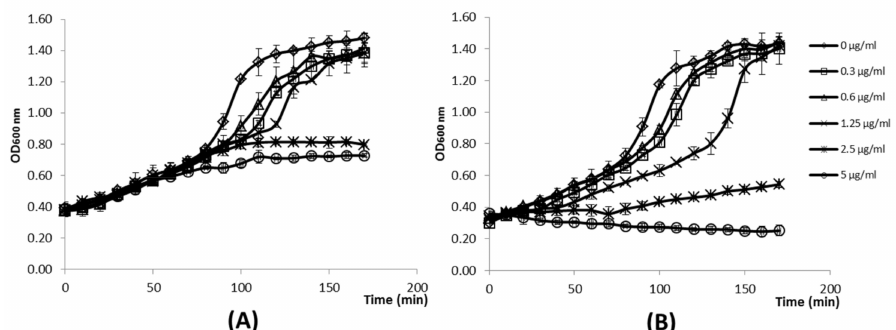
Figure 6. Inhibitory activity of LysTP712 against L. lactis . At time point zero, purified LysTP712 from fraction I ( A ) and fraction II ( B ) containing LysTP712FL only, and the endolysin together with the small polypeptides respectively, were added at 0, 0.3, 0.6, 1.25, 2.5 and 5 µ g / mL of total protein concentration to early-log-phase cultures of L. lactis MG1363. Optical density (OD 600 ) of the cultures was monitored in a microtiter plate reader. Plotted data are the means of results from three independent experiments and standard deviations are shown as error